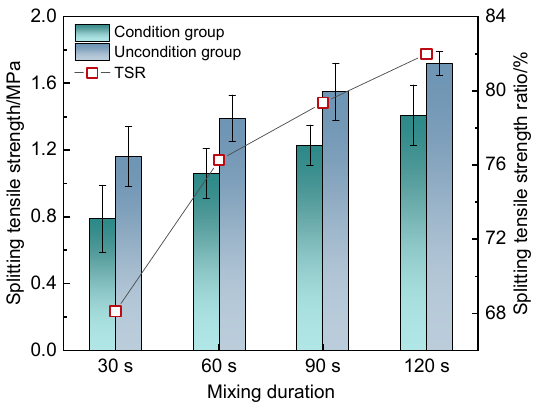
Figure 17. Freeze–thaw splitting results.